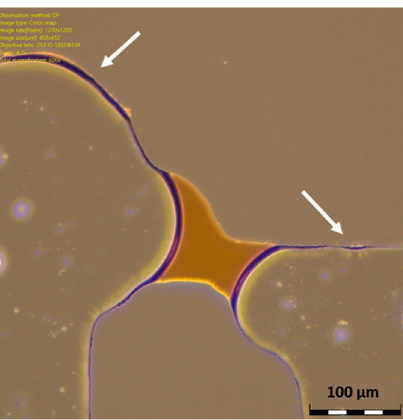
Figure 15. Microscope picture of the wetting layers observed in HO49Y.